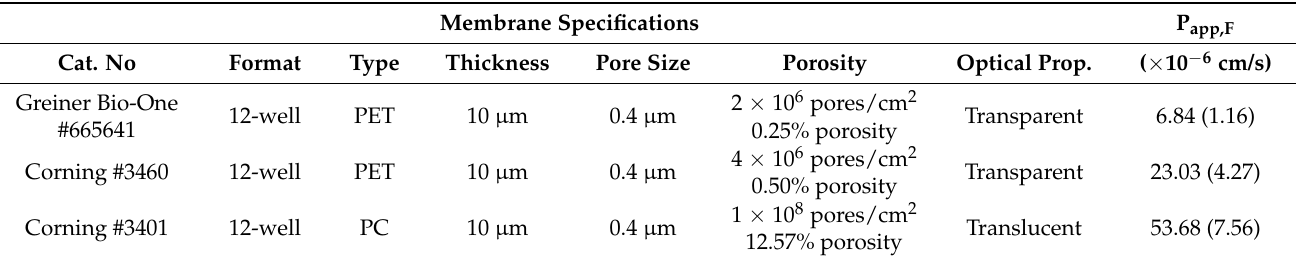
Table 2. Specifications of ThinCert ® and Transwell ® membranes and the apparent permeability of sodium fluorescein across these